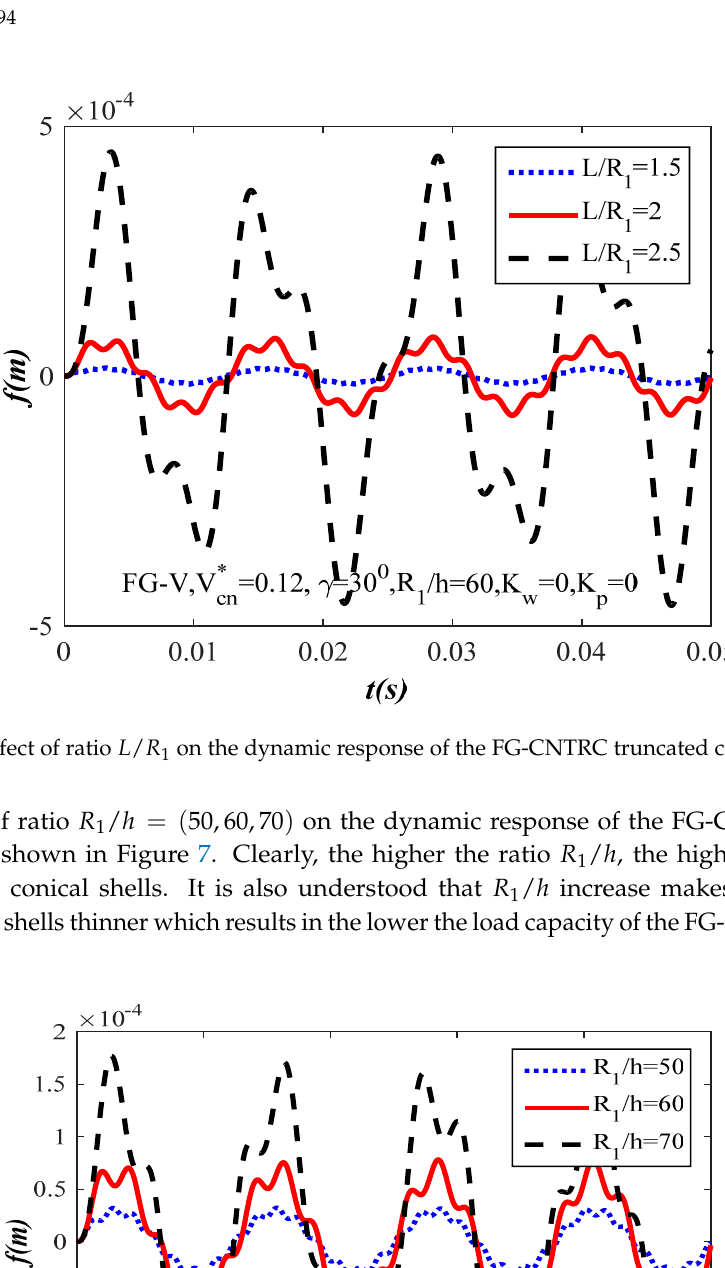
Figure 5. Effect of semi-vertex angle  on the dynamic response of the FG-CNTRC truncated conical shells.